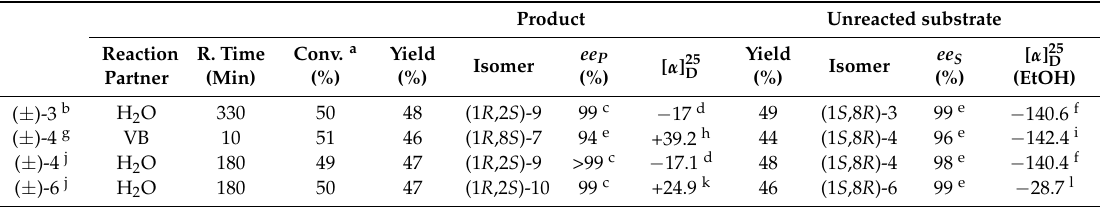
Table 3. Preparative-scale